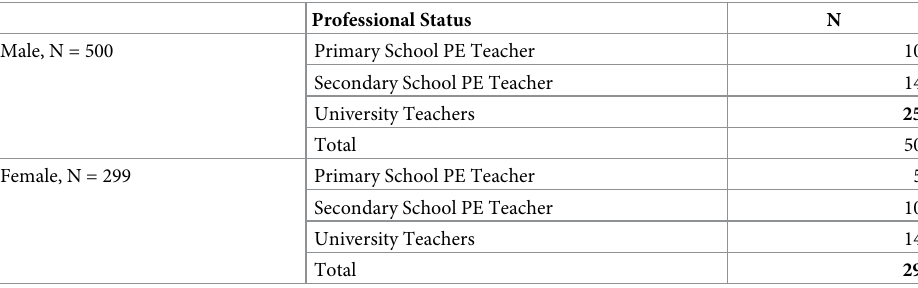
Table 2. Number of participants by gender and professional